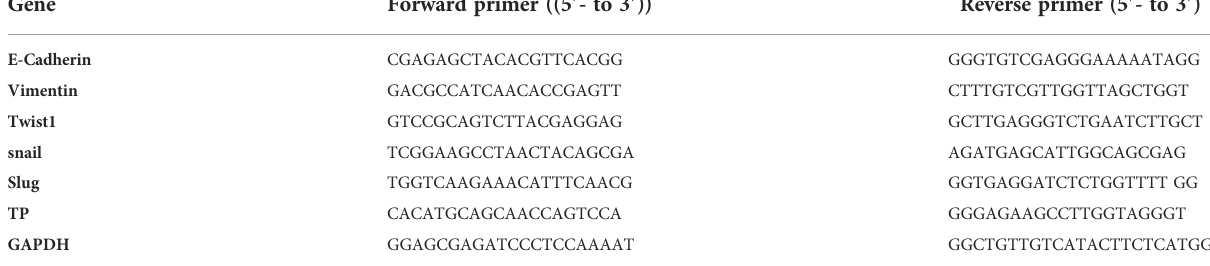
TABLE 1 PCR primer